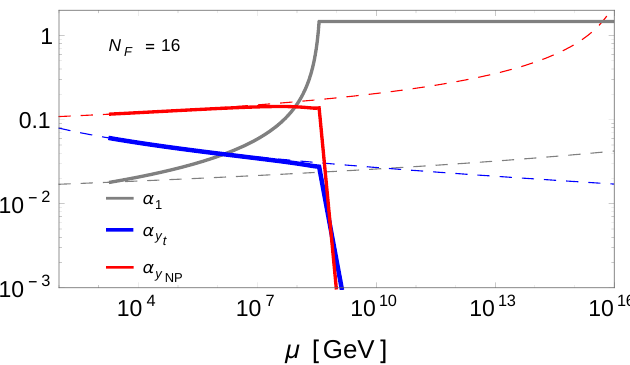
Figure 4 . Modi(cid:12)ed running of the hypercharge U(1) coupling (cid:11) 1 (gray solid), top Yukawa coupling (cid:11) y (blue solid), and the Yukawa coupling (cid:11) y of a model of new physics de(cid:12)ned in the text (red t NP solid) in the presence of N F = 16 vector-like fermions charged under U(1). The common mass of the vector-like fermions is set at 2 TeV. For each coupling, the corresponding 1-loop running without the large N F enhancement is shown with a dashed line of the same